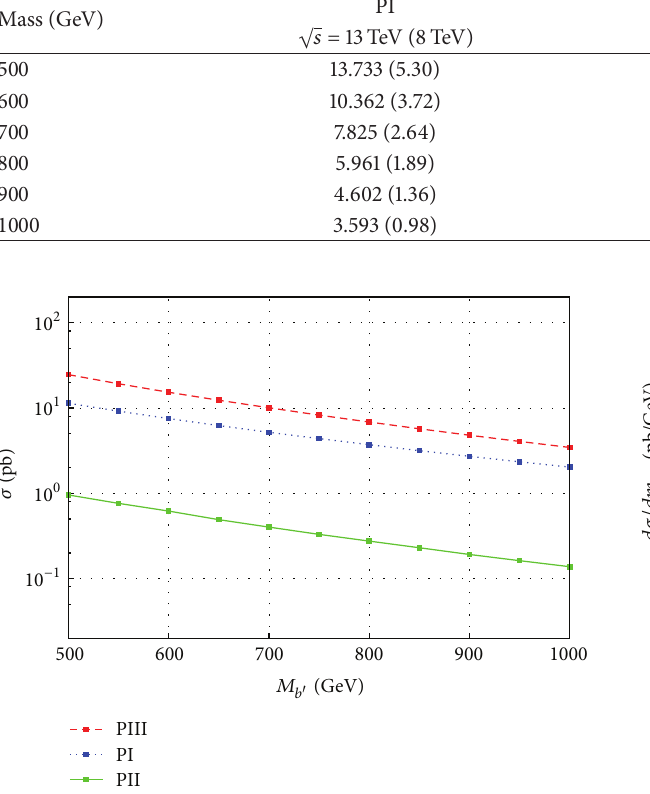
Figure 4: Invariant mass distributions 𝑚 𝑡𝑉 (where 𝑉 = 𝛾 , 𝑔 , and 𝑍 ) for PI parametrization of the signal with 𝜅/Λ = 0.2 TeV −1 and = 700 GeV at the center of mass energy √𝑠 = 13 𝑚 𝑡 󸀠